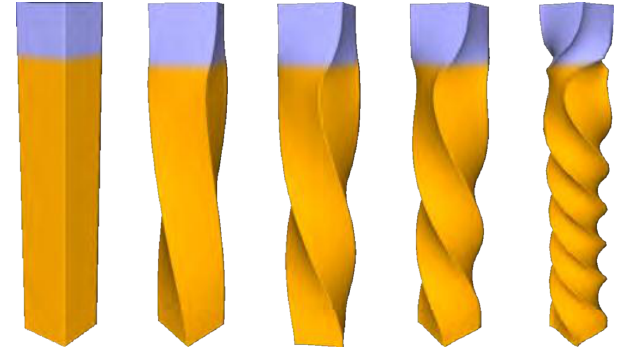
Fig. 6 The selected (orange) vertices of the post are twisted using anisotropic deformation gradients along a global direction. The twist angle increases with height. The torsion frequency is increased from left to right.